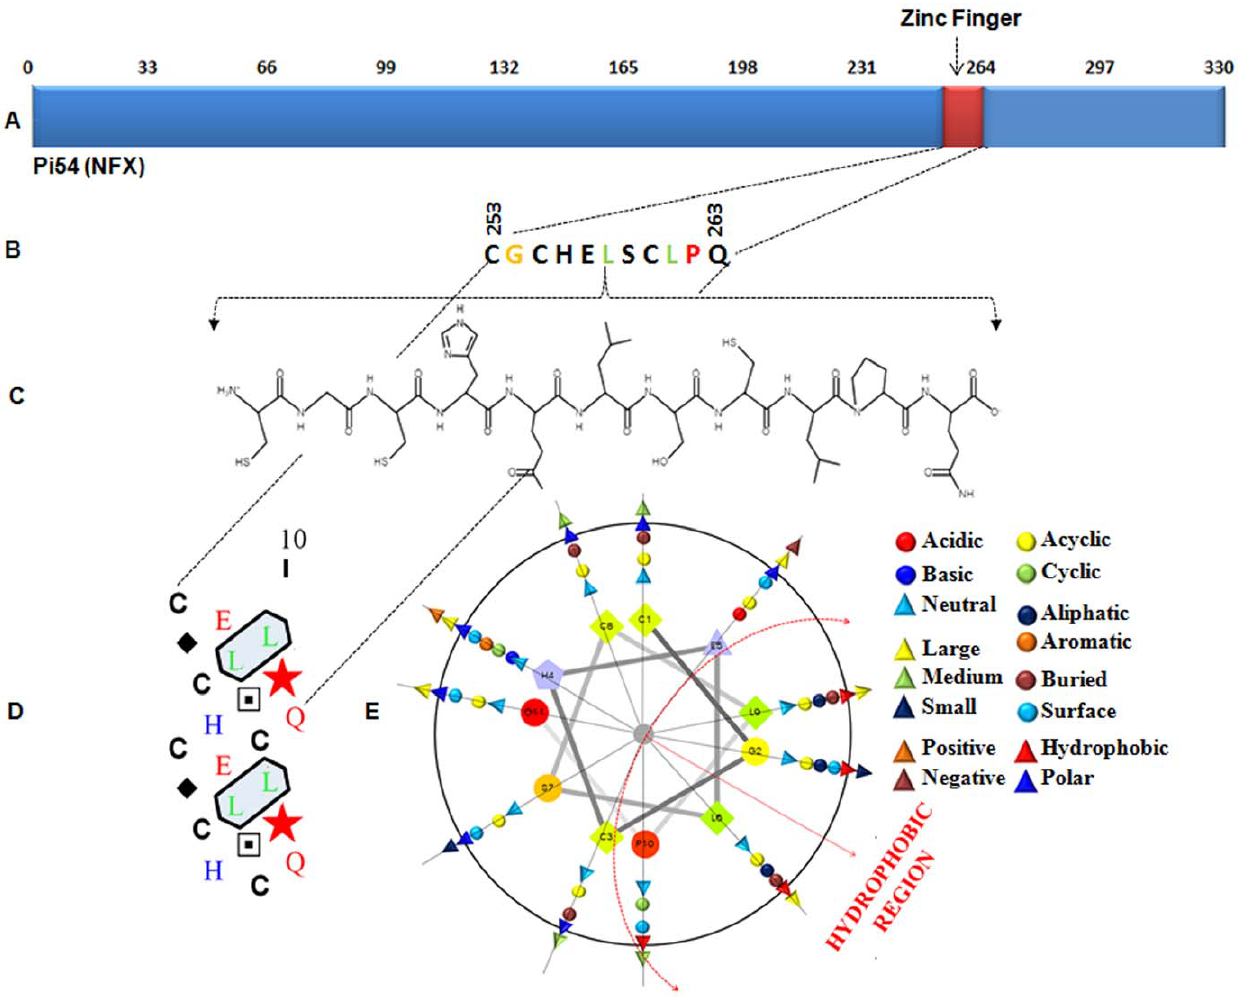
Figure 1. The structure of Pi54 zinc finger domain. (A) Positional analysis of the domain showed that this domain is C- terminal in nature. The type of this zinc finger domain is NFX. (B) The amino acids, numbers and their positions in this domain. (C) Chemical structure of individual amino acids. (D) Secondary structure of zinc finger domain (E) Helical wheel diagram of Pi54 zinc finger domain. The helical wheel is a plot of the amino acid residues around a potentially helical segment. The graphical representation showed the clustering of polar and/or non-polar residues toward one face of a helix.